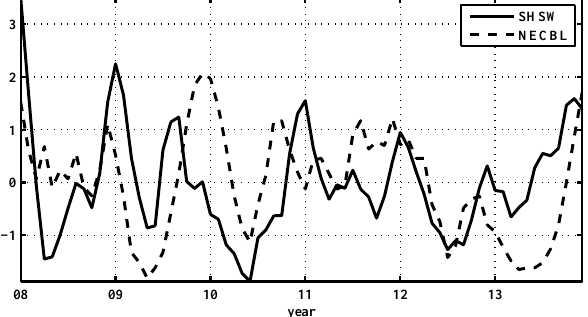
Figure 10. Seasonal variation of the NEC bifurcation latitude (NECBL), the Kuroshio transport (KT), the Luzon Strait transport (LST), and the subsurface high-salinity water (SHSW) in the north- ern SCS (all normalized after applying a 3-month running mean filter; all time series computed in subsurface layers between 23.5 and 25.5 potential